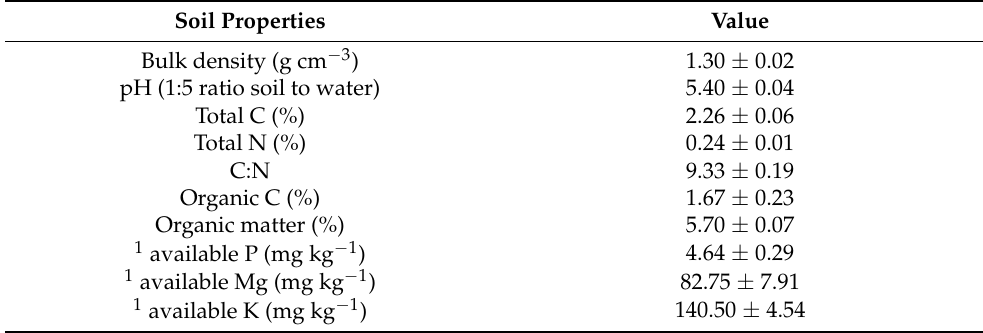
Table 1. Soil characteristics (0–10 cm) of the experimental site with results expressed as mean ± SE ( n =